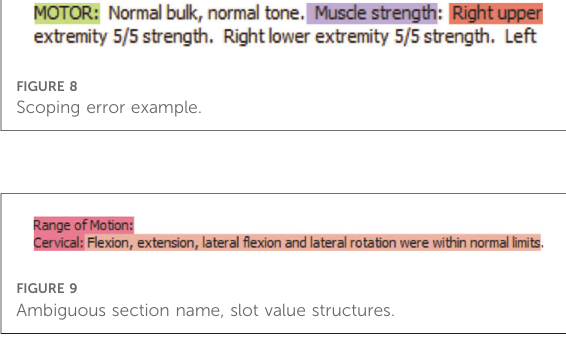
FIGURE 8 Scoping error